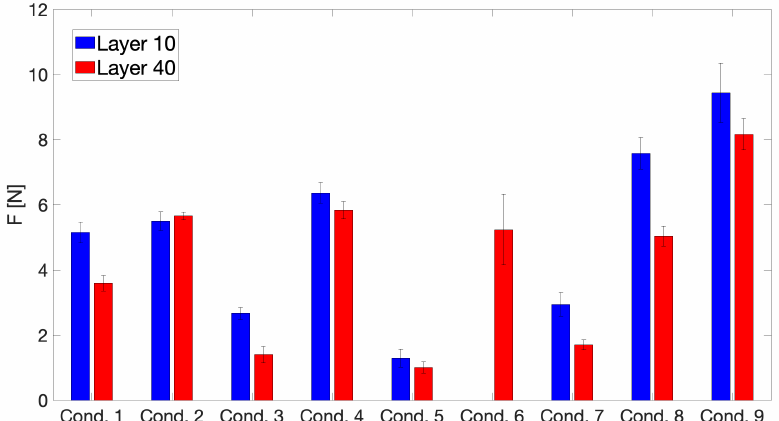
Figure A8. An overview across all printing conditions of the average load for each respective interlayer interface measured through Mode III fracture